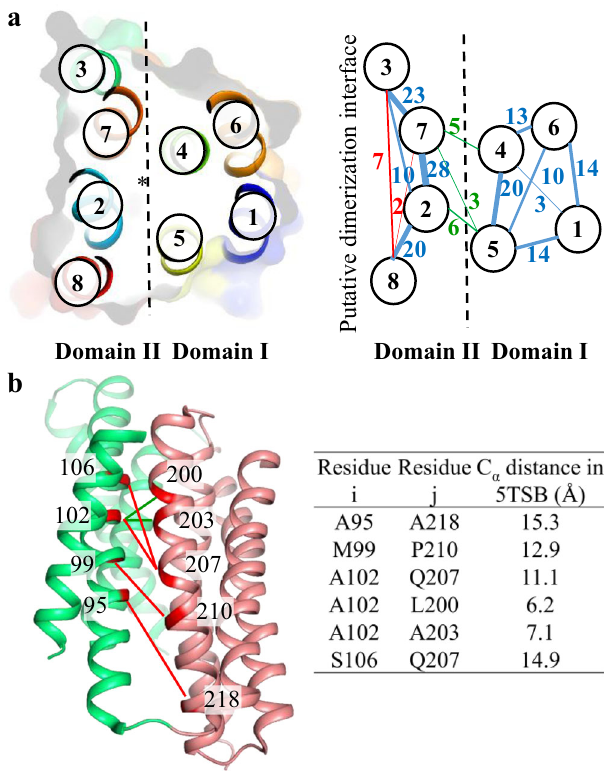
Fig. 4 | Evolutionary covariance analysis of BbZIP. a Mapping of the predicted interhelical interactions (with probability >75%) by Evcouplings to the structure of BbZIP. Left : The cross-section view of BbZIP in cartoon and surface modes are labeled with TM numbers. The structure is divided by the dashed line into two domains with the asterisk marking the transport pathway. Right : The interhelical interactions are indicated by the lines connecting the involved TMs. The numbers of interhelical interactions are labeled beside the lines, and the thickness of the lines is proportional to the number of interhelical interactions. The intradomain interactions within Domain I orDomain II arein blue, the interdomain interactions are in green, and the predicted interactions allowed only in dimeric BbZIP are in red. b Mappingoftheinteractionsbetween α 2and α 5totheIFCstructureofBbZIP (PDB entry ID: 5TSB). The interactions consistent with the IFC structure are shown as green lines, whereas the interactions inconsistent with the IFC structure are shown as red lines. The distances of the C α atoms of the involved residues in 5TSB are listed in the table.